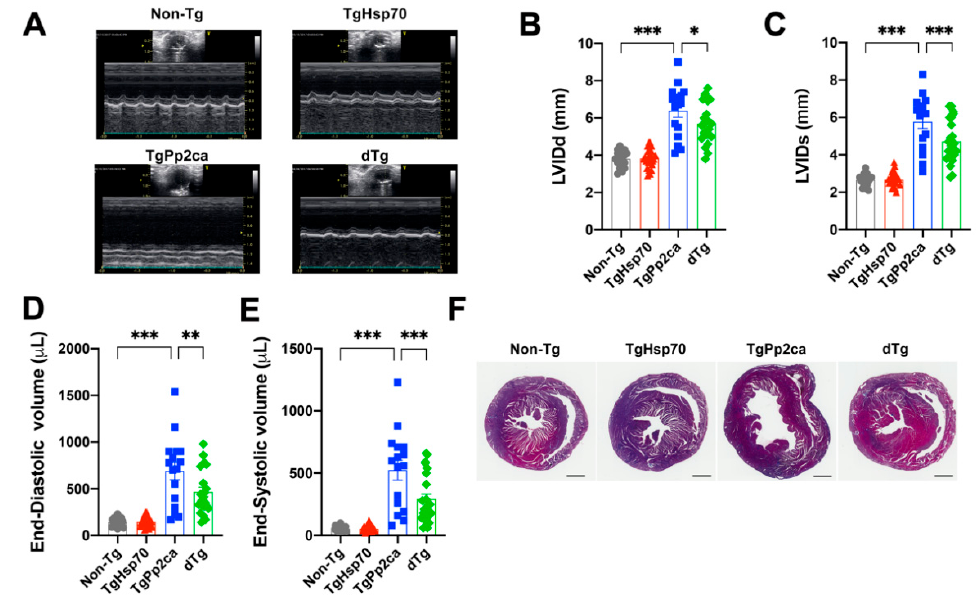
Figure 2. Cardiac geometry in echocardiogram measurements. ( A ) Representative M-mode echocardiograms from a mouse in each group. ( B,C ) Ventricular enlargement. Left ventricular (LV) internal diameter at diastole (LVIDd, B ) and systole (LVIDs, C ), which represents the LV chamber size at the papillary muscle level. LV cavity enlargement was predominant in TgPP2CA mice but was attenuated in dTg mice. ( D , E ) Global remodeling. End-diastolic volume ( D ) and end-systolic volume ( E ) in each group of transgenic mice. Fatal LV remodeling observed in TgPP2CA mice was ameliorated in dTg mice. ( B – E ) Cohort size, nTg: 18, TgHSP70: 27, TgPP2CA: 16, dTg: 23. ( F ) Representative heart morphology. Scale bars = 1 mm. Statistical significance was assessed using ANOVA with LSD post hoc test. Asterisks indicate statistical significance: * p < 0.05; ** p < 0.01; *** p < 0.001.